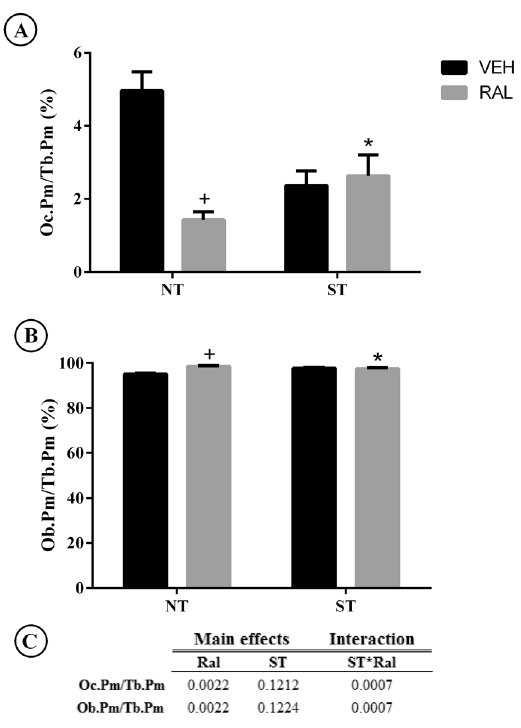
Figure 7. Osteoclast perimeter/Trabecular perimeter (Oc.Pm/Tb.Pm) and Osteoblast perimeter/Trabecular perimeter (Ob.Pm/Tb.Pm) assessed in TRAP positive cells by immunohistochemistry counterstaining with hematoxilin and eosin, analyzed by Image J. ( A ) Oc.Pm/Tb.Pm (%), ( B ) Ob.Pm/Tb.Pm (%), ( C ) summary of p values in two way ANOVA analysis, n = 7 animals/group. Abbreviations and symbols + main effect of Ral, * interaction of ST plus Ral. NT-Veh = non-trained and treated with vehicle; NT-Ral = non-trained and treated with raloxifene; ST-Veh = strength training and treated with vehicle; ST-Ral = strength training and treated with